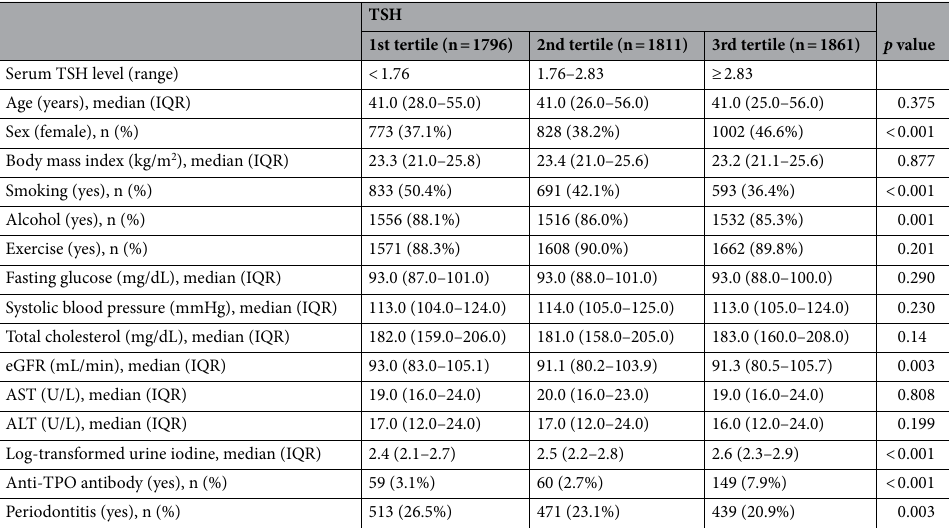
Table 1. Baseline characteristics of study participants according to TSH tertiles. AST aspartate transaminase, ALT alanine transaminase, eGFR estimated glomerular filtration rate, IQR interqurtile range, TPO thyroid peroxidase, TSH thyroid-stimulating